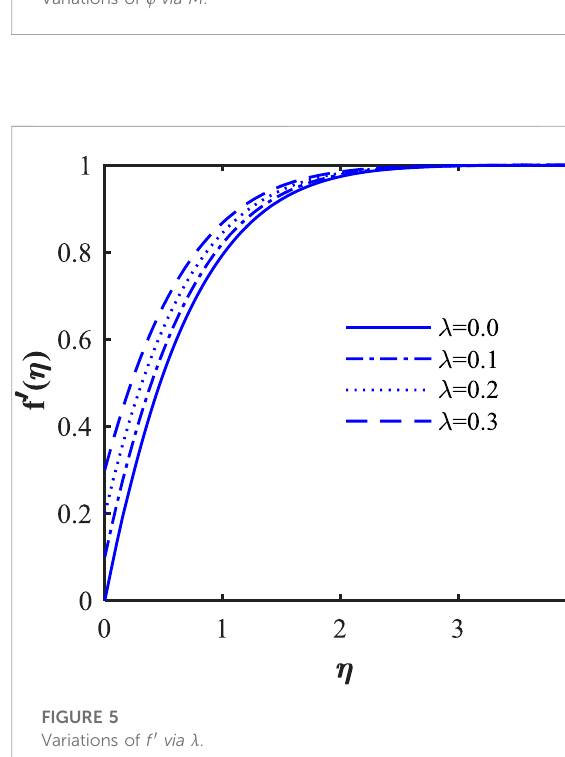
FIGURE 4 Variations of ϕ via M .